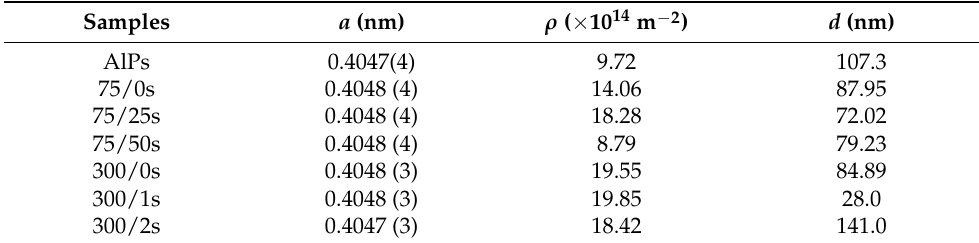
Table 2. Results from Rietveld and CMWP software.